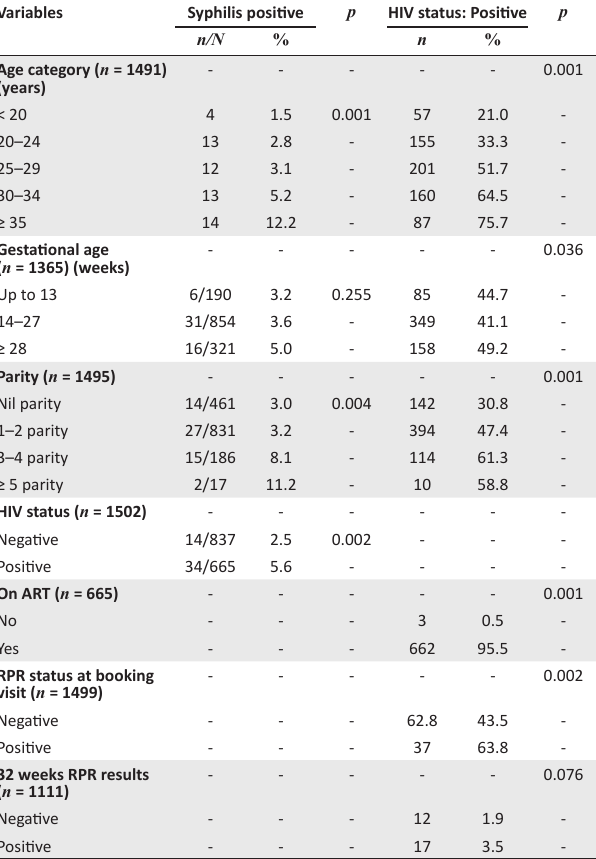
TABLE 2 : Cross table analysis of syphilis and human immunodeficiency virus prevalence with demographic and obstetric variables at the booking visit with Chi-square and p -values.